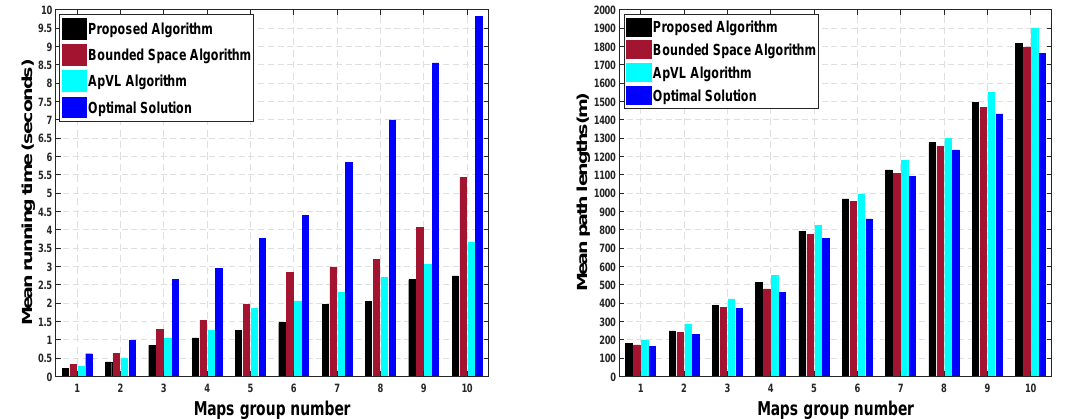
Figure 7. ( Left ): Running time: Proposed algorithm versus bounded space algorithm, ApVL algorithm and optimal solution. ( Right ): Path Lengths: Proposed algorithm versus bounded space algorithm, ApVL algorithm and optimal